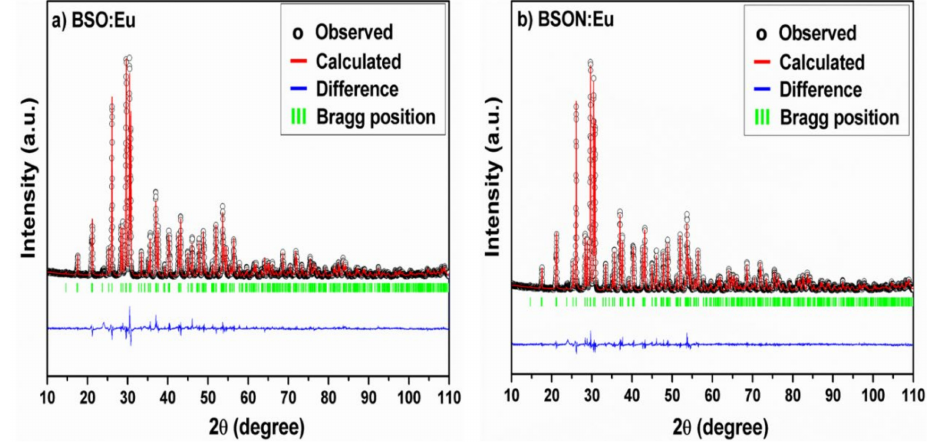
Figure 1. Rietveld refinement profiles of the X-ray di ff raction (XRD) patterns for BSO:Eu ( a ) and BSON:Eu ( b ).